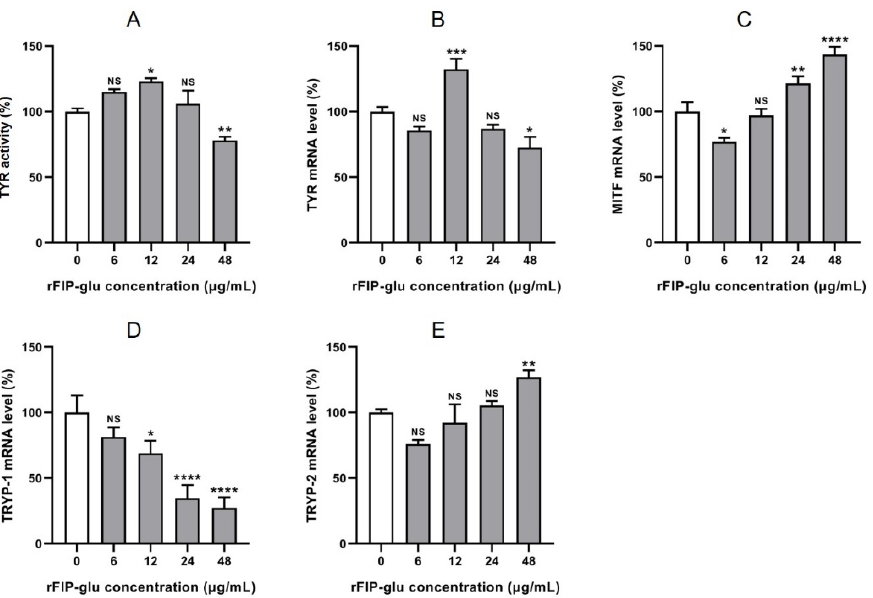
Figure 6. The e ff ects of rFIP ‐ glu on tyrosinase activity and mRNA expression of related genes in B16 cells. Tyrosinase activity ( A ); mRNA expression of TYR ( B ), MITF ( C ), TYRP ‐ 1 ( D ), and TYRP ‐ 2 ( E ). Data are expressed as means ± SD (n = 3). NS, p > 0.05; *, p ≤ 0.05; **, p ≤ 0.01; ***, p ≤ 0.001; ****, and p ≤ 0.0001 versus the control group.